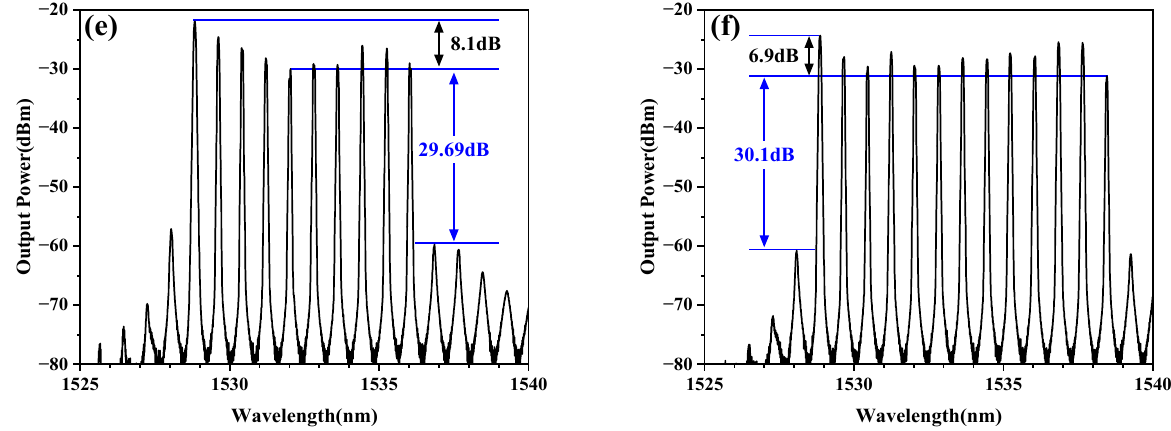
Figure 6. Output spectra of ( a ) single-; ( b ) triple-; ( c ) quintuple-; ( d ) septuple-; ( e ) decuple-; ( f ) thirteen-wavelength.